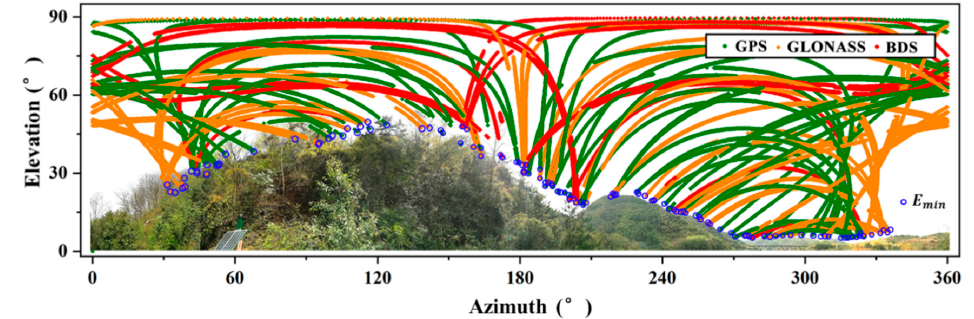
Figure 2. All the trajectories of GNSS satellites in the elevation and azimuth domain of 24 h corresponding to Figure 1, as well as the scatter pointers E min .